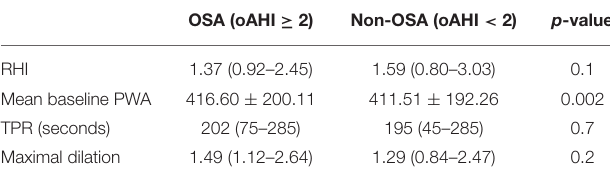
TABLE 2 | Endothelial function parameters of patients with (oAHI ≥ 2) and without (oAHI < 2) obstructive sleep apnea at